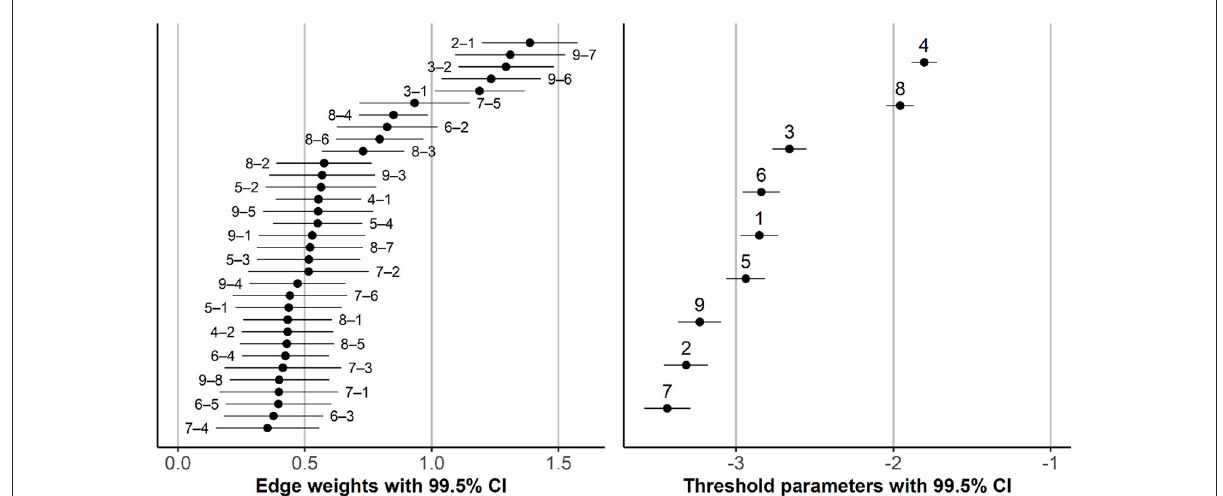
FIGURE3 Edge weights (interaction parameters) and thresholds, with confidence intervals. Numbers in the plots indicate items: 1 = Preoccupation, 2 = Tolerance, 3 = Withdrawal, 4 = Persistence, 5 = Displacement, 6 = Problem, 7 = Deception, 8 = Escape, and 9 = Conflict. Number pairs (in the left plot) indicate which items the edge connects (e.g., “2–1” references the edge between Item 2 and Item